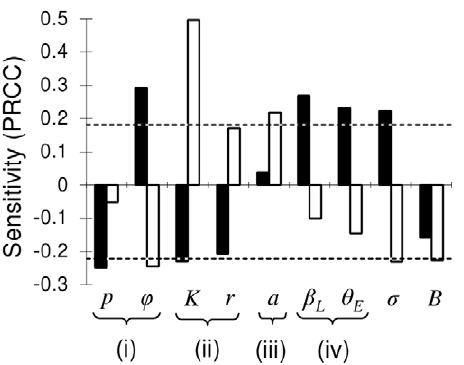
Figure 3. Multi-parameter sensitivity analysis. Partial rank correlation coefficients (PRCCs) between extinction (black bars) and enzootic (white bars) probabilities and model parameters. Dashed lines indicate the critical values for significance (p , 0.05). Parameters are grouped by the following: (i) host resistance, (ii) host population size, (iii) efficiency of the flea reservoir, and (iv) efficiency of the booster-feed infection cycle.